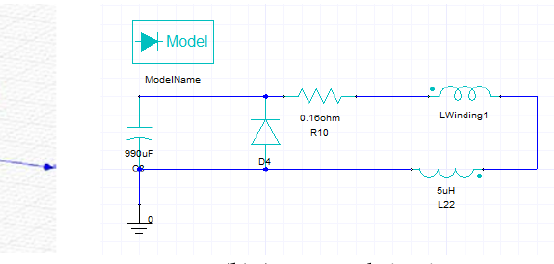
Figure 8. Electro-dynamic simulation model.